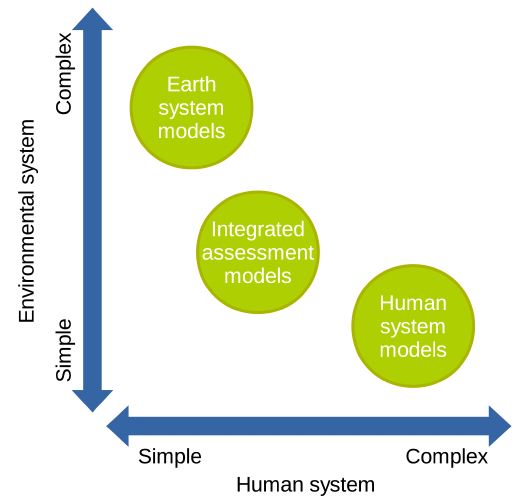
Figure 1. Different models relevant for integrated sustainable de- velopment/planetary boundaries